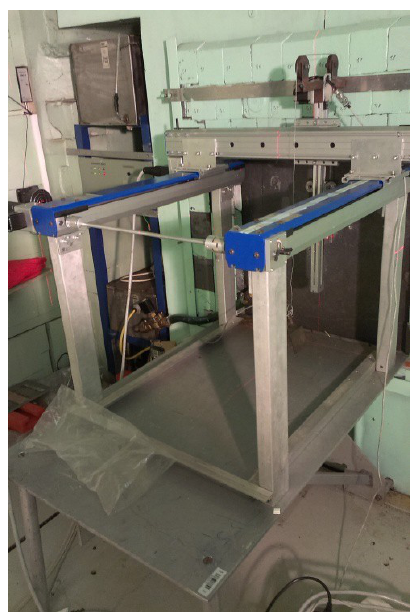
Figure 1. The special positioning